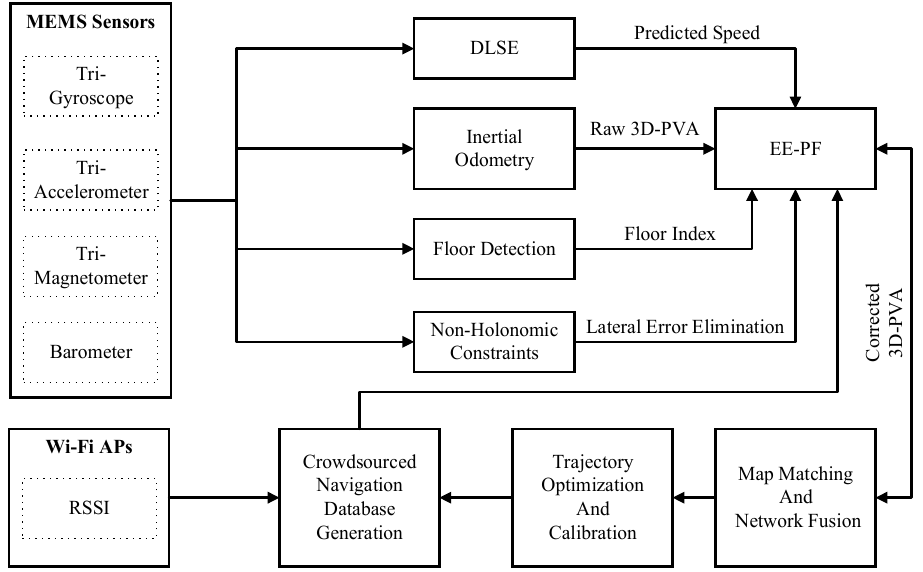
Figure 1. The Framework of Proposed ML-CTEF.